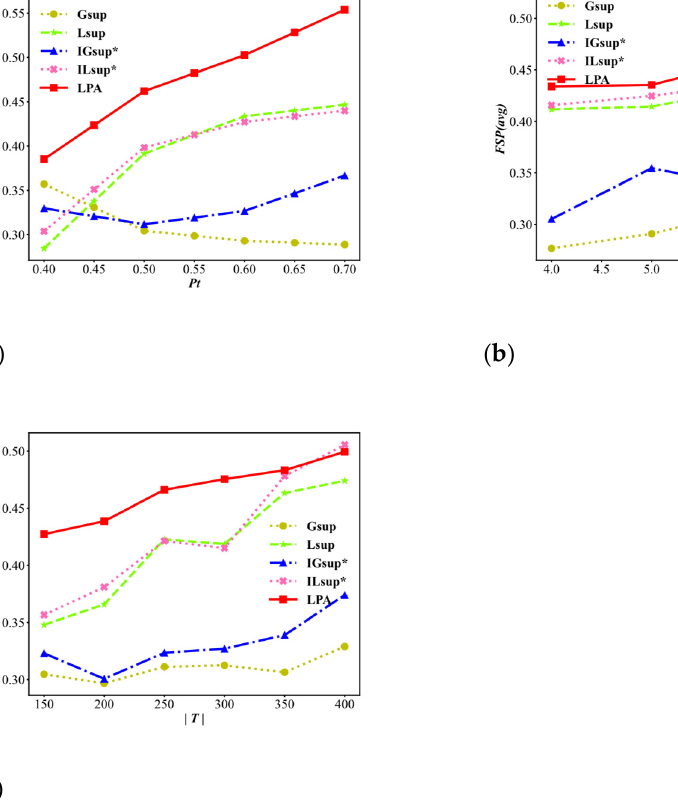
Figure 9. Average published frequent sequential pattern remaining ratio FSP ( avg ) (higher is better). ( a ) Varying P t . ( b ) Varying | t | (avg). ( c ) Varying | T | .